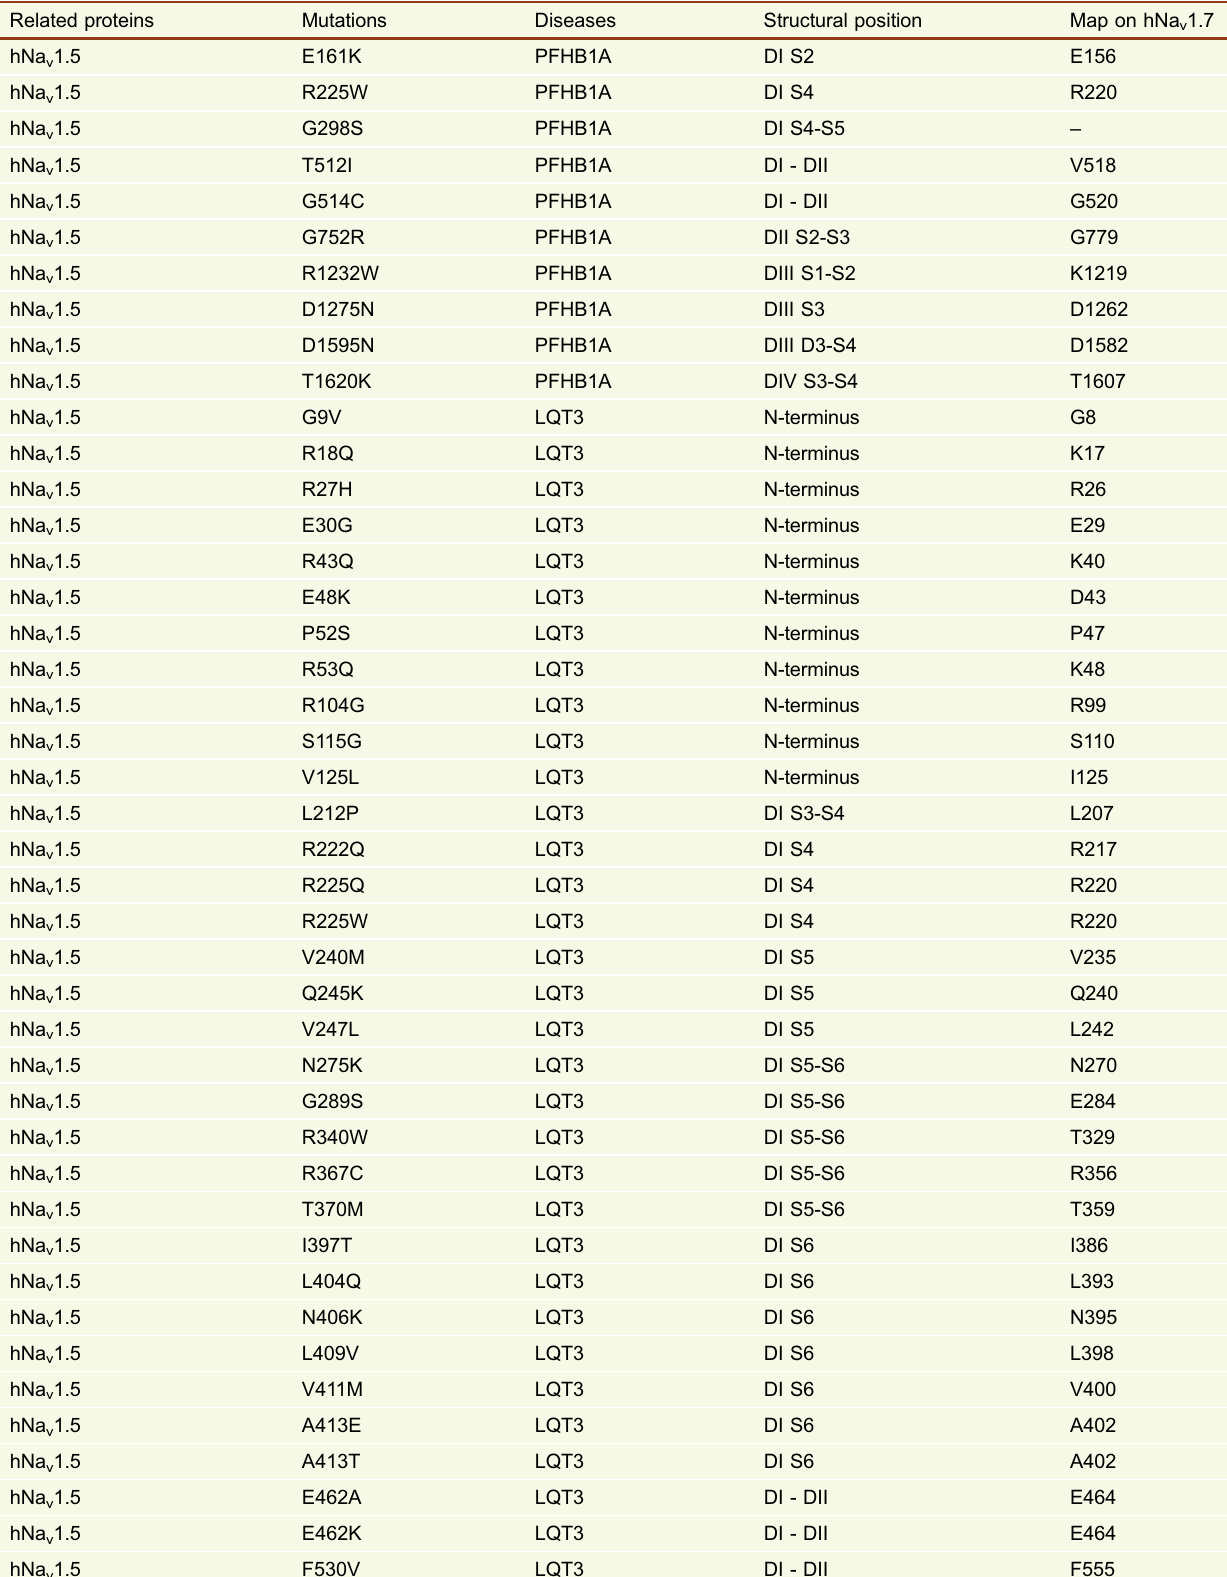
Table 6. Structural mapping of disease-related mutations identi fi ed in human Na v